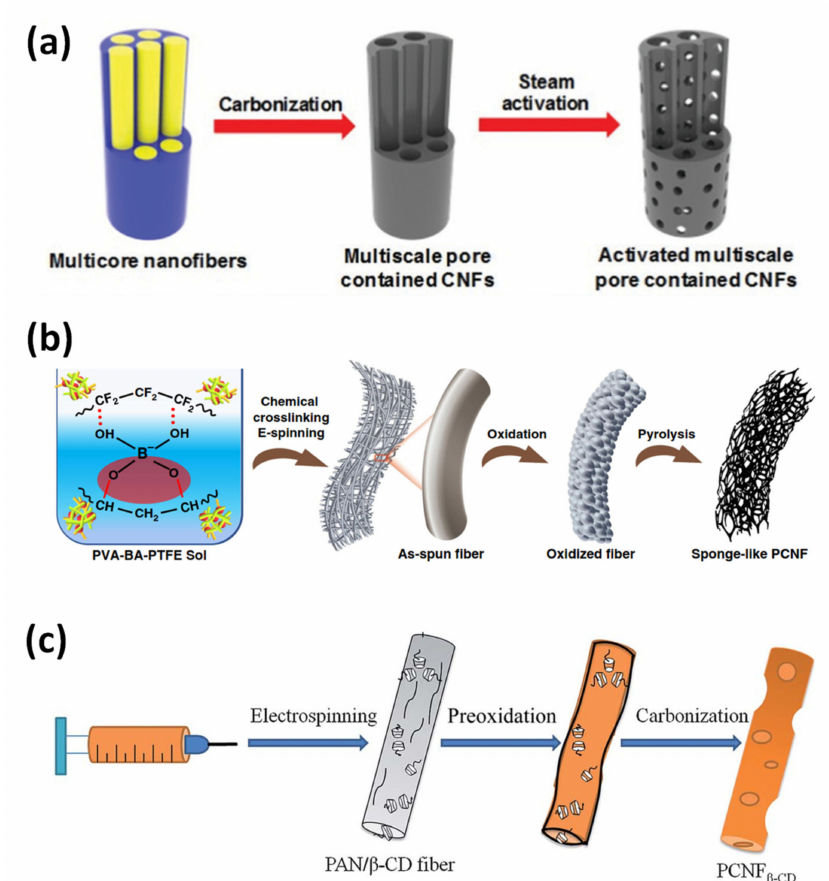
Figure 8. ( a ) Fabrication of multiscale porous CNFs from PAN and PS using steam activation [70]. ( b ) Fabrication of sponge − like CNFs using PTFE particles and PVA [72]. ( c ) Fabrication of porous CNFs using PAN and β -CD precursors